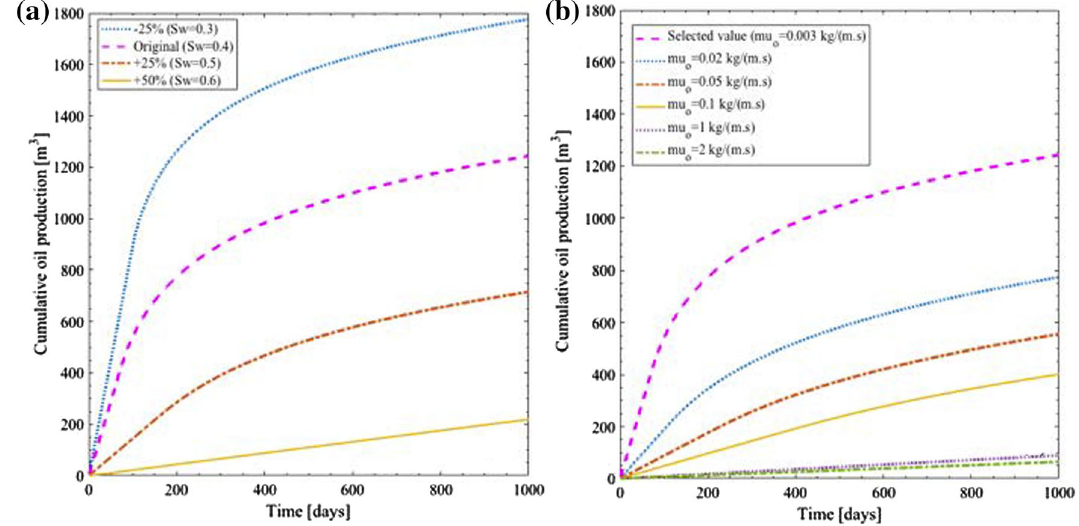
Fig. 8 Variation of cumulative oil production with a initial water saturation ( S